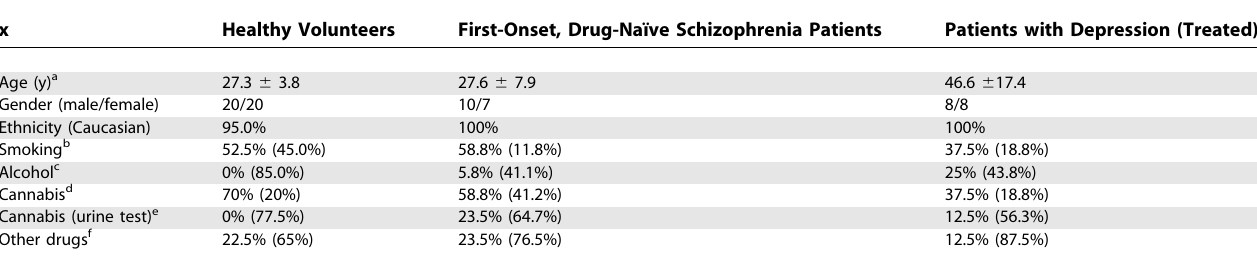
Table 2. Demographic Details of Subjects in the CSF Validation Sample